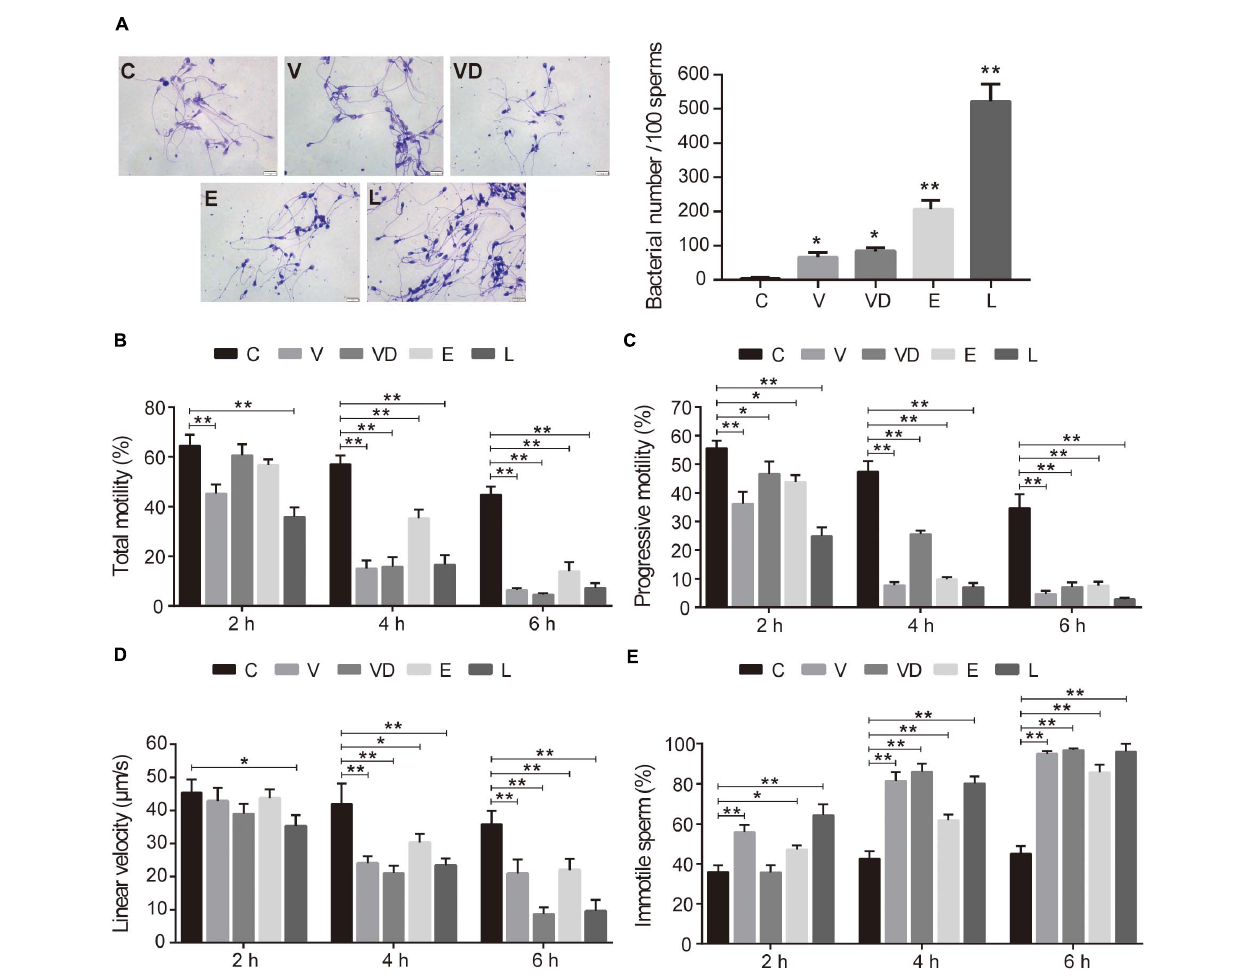
FIGURE 1 | The effect of tested bacteria on sperm motility and the adhesion to sperm in vitro . (A) The gram stain results (magnification, × 100) and adhesion numbers of PBS, VNP20009, VNP20009 DNase I, E. coli O157:H7, and L. crispatus . The initial sperm/bacteria ratio was 1:10, and the bacteria were available in-house. Human ejaculated sperm were incubated with a single species of bacteria in HTF medium in an incubator at 37 ◦ C and 5% CO 2 for 2, 4, and 6 h, respectively. The motion parameters including (B) total motility, (C) progressive motility, (D) linear velocity, and (E) immotile sperm were analyzed by computer-assisted sperm analysis. For exactly assessing the sperm viability, a minimum of 200 sperms were counted for each assay. The data represent means ± SD of three independent experiments. * P < 0.05, ** P < 0.01. SD, standard deviation; C, control; V, VNP20009; VD, VNP20009 DNase I; E, E. coli O157:H7; L, L. crispatus